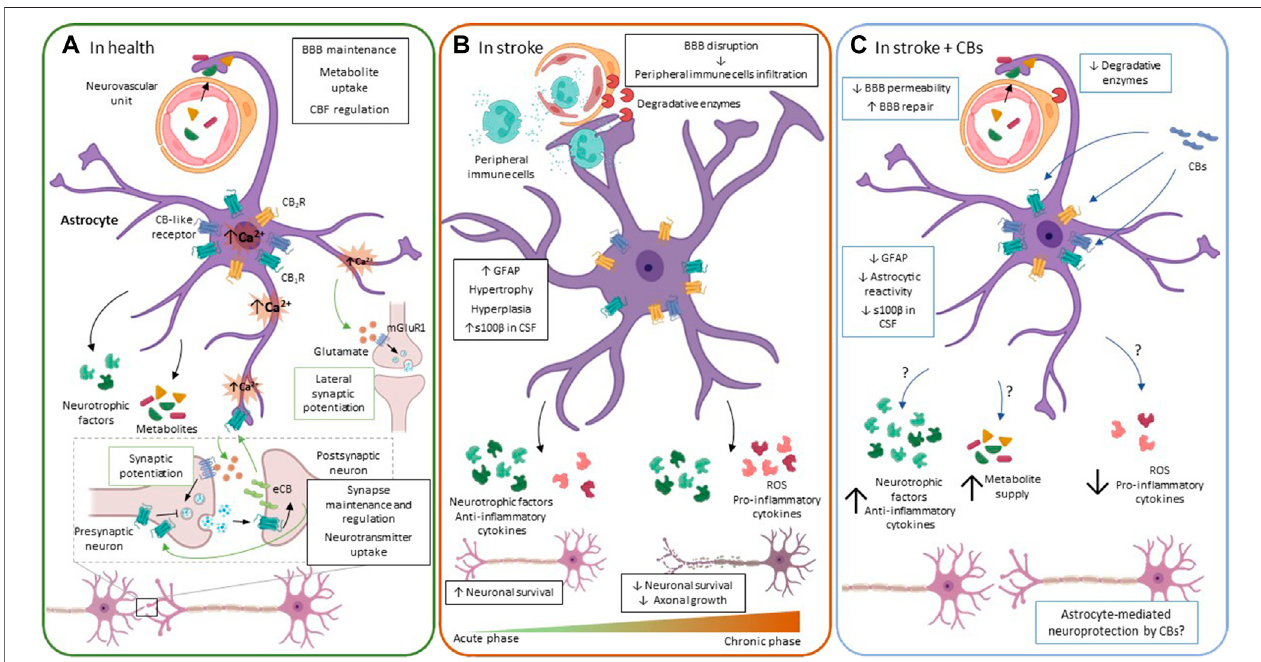
FIGURE 2 | The ECS functioning in astrocytes. (A). In physiological conditions, astrocytes regulate processes that are crucial for neuronal functioning, e.g., providing metabolic and trophic support for neurons, controlling CBF, BBB permeability, and regulating synapse maintenance and plasticity, among others. Astrocytes participate in synapse plasticity through the tripartite synapse. When neurotransmitter is released by presynaptic neurons, it increases intracellular Ca 2+ both in post- synaptic terminals and in astrocytes. In post-synaptic neurons, Ca 2+ elevation induces eCB release to the extracellular space, inhibiting neurotransmitter release from the presynaptic neuron. In astrocytes, eCB binding to their receptors mobilize Ca 2+ from internal stores, triggering gliotransmitter release, i.e., glutamate, which in turn promotes mGluR1-mediated neurotransmitter release from the presynaptic neuron, a phenomenon called synaptic potentiation. Besides, as Ca 2+ spreads intracellularly in the astrocyte, it is able to release glutamate at distal points, stimulating synapsis that are at a certain distance from the synapse that was initially stimulated. This results in the so-called lateral synaptic potentiation. (B). During the acute/subacute phase after an ischemic event, astrocytes undergo signi fi cant morphological and functional changes like hypertrophy, hyperplasia and increased GFAP levels. To increase neuronal survival, astrocytes release neurotrophic factors andanti-in fl ammatorycytokines.Nevertheless,theyalsoreleasepro-in fl ammatorycytokinesthatnegativelyaffectneuronalsurvival.Moreover,attheneurovascularunit, astrocytes upregulate the expression of surface receptors and enzymes that are strongly associated with in fl ammatory responses that actively contribute to BBB disruption and leukocyte in fi ltration intothe CNS,becoming asource ofin fl ammationif thisprocess becomeschronic.Over time, reactive glial cells rearrange, creating a barrier composed of densely packed cells that separate the ischemic core from the penumbra. (C) . Main molecular changes induced in astrocytes by CBs after stroke. CB modulation of astrocyte reactivity includes reduced GFAP immunoreactivity and release of catalytic enzymes, leading to attenuation of BBB disruption. These molecules also increase neuronal survival after ischemia; however, it remains unclear whether the neuroprotection exerted by CBs is mediated by astrocytes. Green arrows and boxes: eCB-mediated effects; blue arrows and boxes: CB-mediated effects. BBB: brain-blood barrier; CB 1 R: cannabinoid receptor 1: CB 2 R: cannabinoid receptor 2; CBs: cannabinoids; CSF: cerebrospinal fl uid; eCB: endocannabinoids; ROS: reactive oxygen